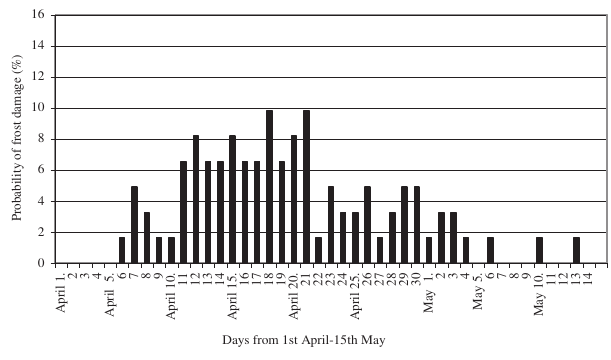
Figure 7 – Probability of suffering frost during blooming in susceptible apricot and peach varieties (Debrecen-Pallag, 1951–2010)